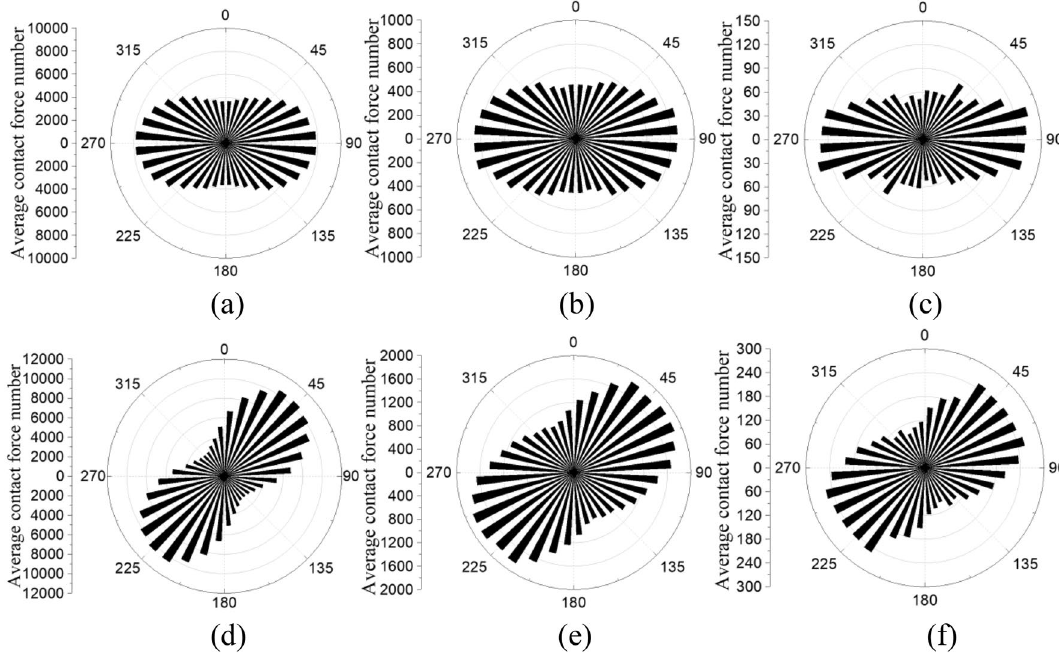
Figure 10. Distribution of average contact number: ( a ) 1D after consolidation, ( b ) 2D after consolidation, ( c ) 4D after consolidation, ( d ) 1D at 40% shear strain, ( e ) 2D at 40% shear strain, ( f ) 4D at 40% shear strain.